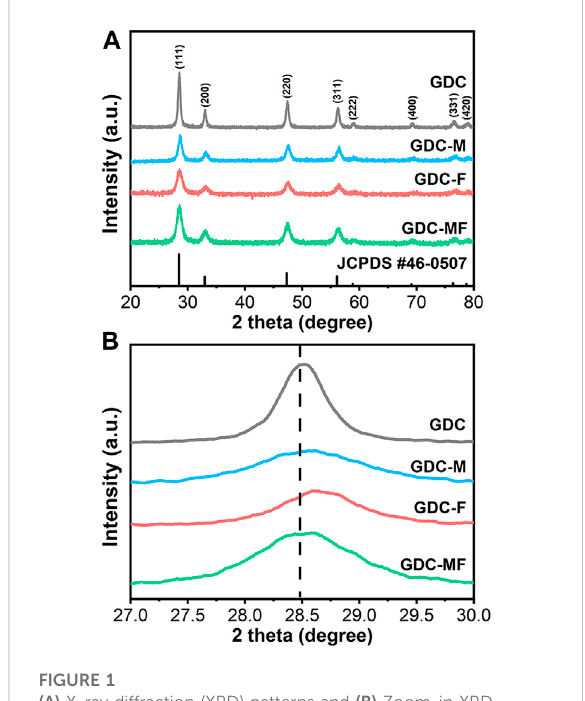
FIGURE 1 (A) X-ray diffraction (XRD) patterns and (B) Zoom-in XRD patterns in a2 θ range of 27.00 – 30.00 ° ofGDC-based electrolytes.